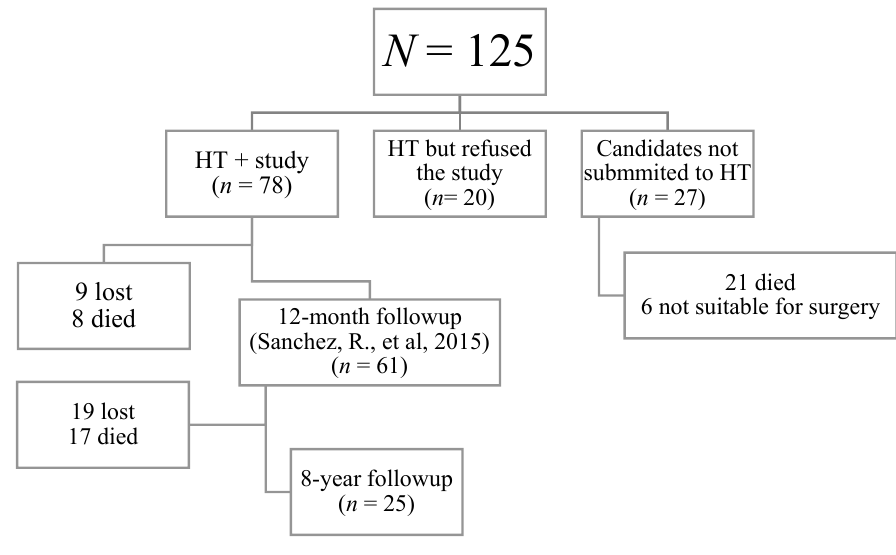
Figure 1. Flowchart of the candidates.